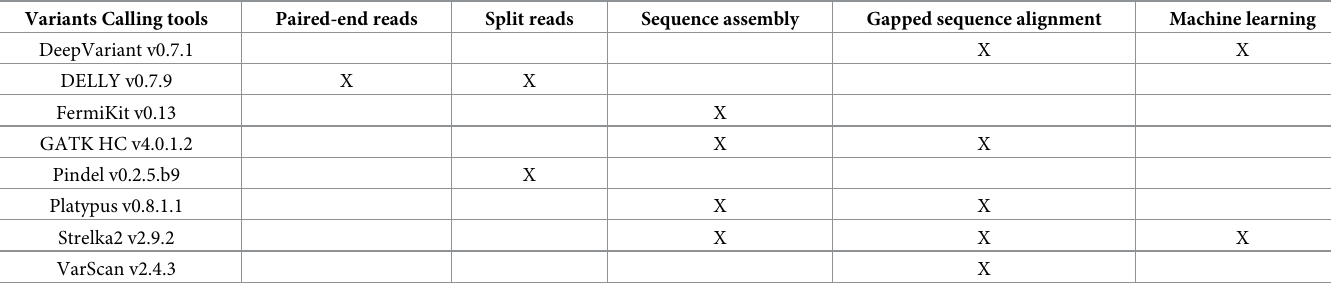
Table 1. Methodological strategies of the tools included in this